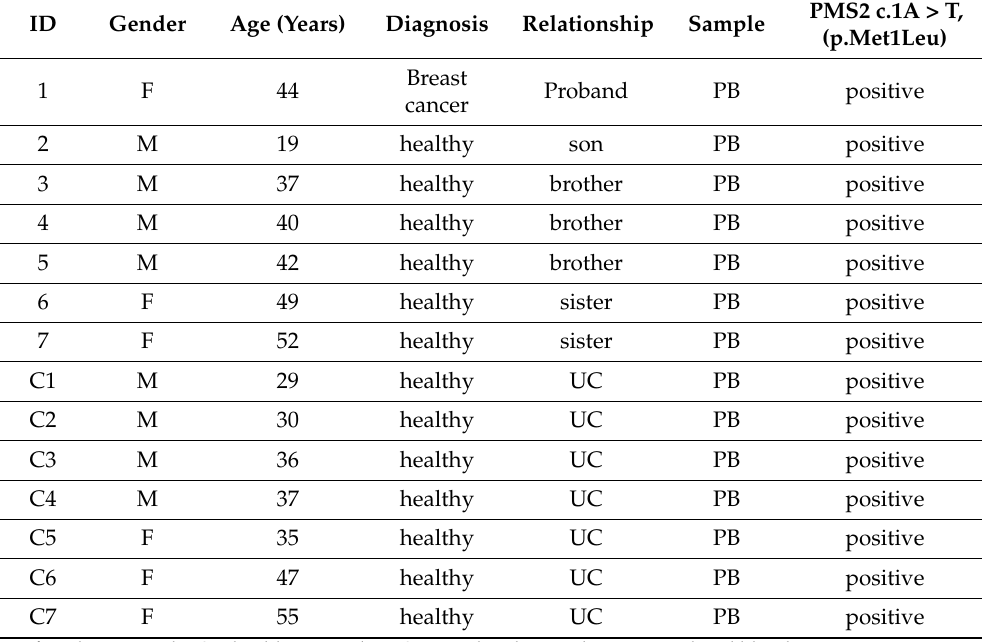
Table 1. Prevalence in family tracts and unrelated healthy individuals of the variant c.1A > T, (p.Met1Leu) in PMS2 . ID Gender Age (Years) Diagnosis Relationship Sample